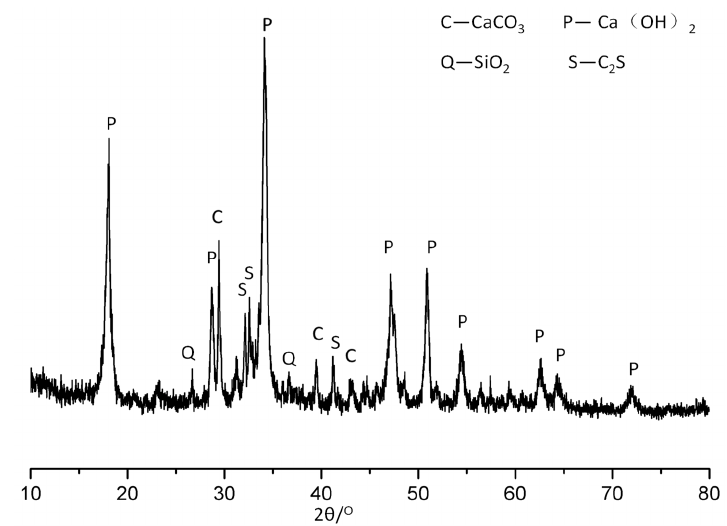
Figure 1. X-ray diffraction pattern of NHL2. Figure 1. X-ray di ff raction pattern of NHL2. Table 1. Chemical composition of NHL2 (wt %).